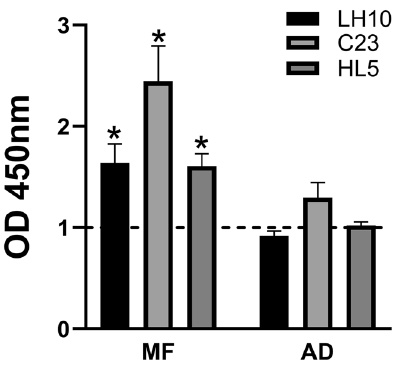
Figure 5. LH10, C23 and HL5 clones are more reactive with microfilariae extract specific IgG. IgG responses to selected clones were analyzed with the use of sera from rats immunized with D. repens adult worm (AD) and microfilariae (MF) extracts. Results are expressed as fold change IgG responses compared to control rat’s serum (dashed line). Plates were coated with 1.46 × 10 11 pfu/well of LH10/C23/HL5 clones in TBS. Blocking step was performed in 0.1 M NaHCO 3 , 0.5% BSA and plates were washed three times. Rats sera were used in 1:800 dilution in blocking buffer. After six washes, secondary anti-rat IgG-HRP antibodies were used in a dilution of 1:5,000 in blocking buffer. The bars show mean ± SEM. The statistically significant differences between examined groups are marked with an asterisk: * p <